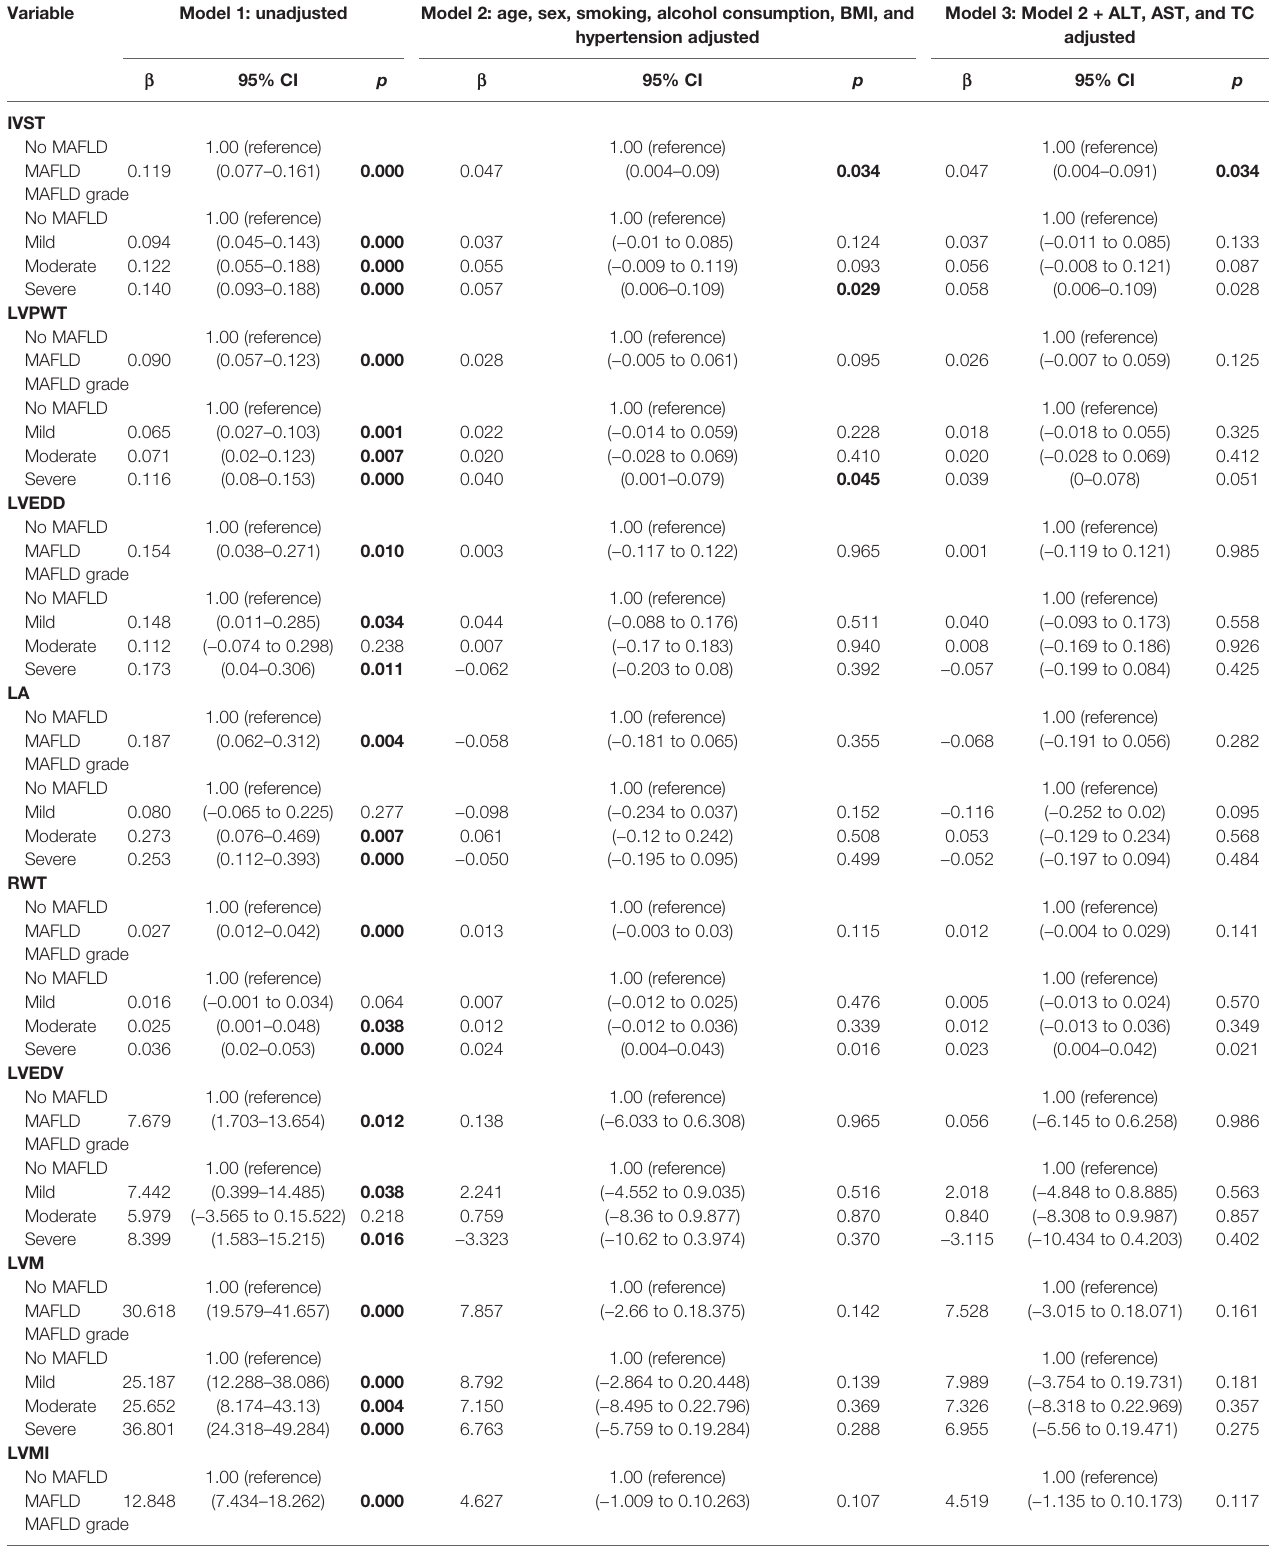
TABLE 7 | Multivariable linear regression analysis assessing the in fl uence of severity of MAFLD on echocardiographic markers of myocardial morphology. Variable Model 1: